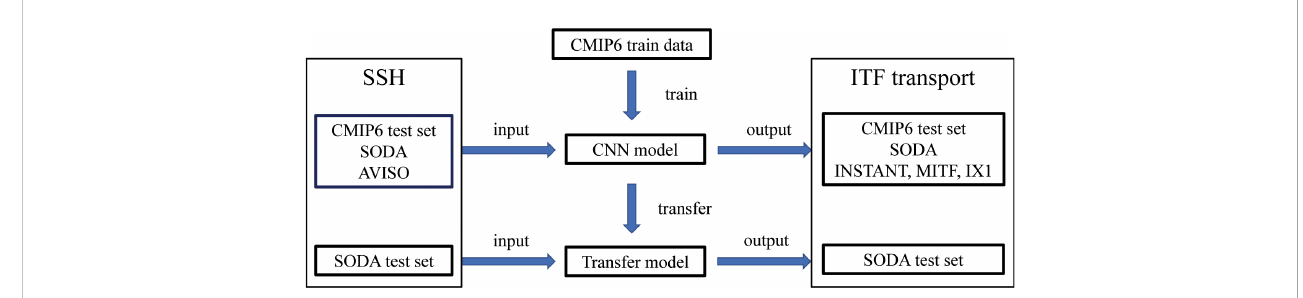
FIGURE 2 A schematic diagram displaying the training and operation of a CNN model with various